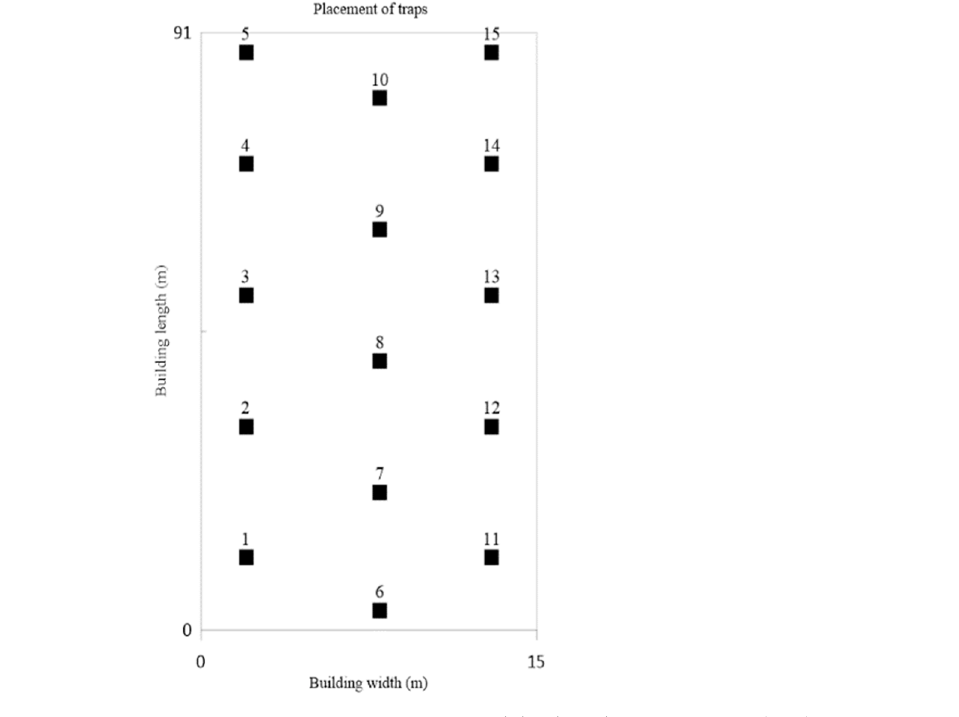
Figure 1. Setting up traps against Alphitobius diaperinus in poultry houses.